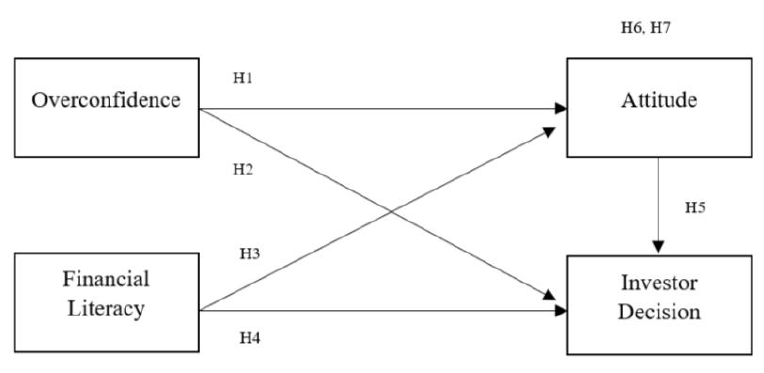
Figure 1: Conceptual Model of the Study; Source: